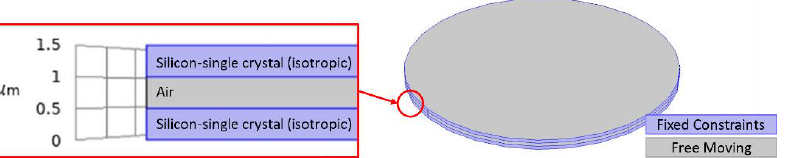
Figure 18. COMSOL Multiphysics ® software simulated clamped membrane geometry with a 40 µ m diameter. The top and bottom layers are composed of silicon-single crystal (isotropic) and the middle layer is an air cavity. The thickness of the top and bottom membranes and the air cavity height are 0.5 µ m each. Boundaries shown in blue are fixed while the grey boundaries are free to move. Frequency shift versus mass change is shown in Figure 19 for a silicon capacitive clamped membrane mass sensor with 40 μm diameter when the thickness of the top and bottom membrane and the cavity height were 0.5 μm. In these FEA simulations, the ca- pacitive membrane was fully clamped, and the sensor was biased with 20 V DC, which is chosen close to the device’s pull-in voltage, which results in a deflection towards the grounded bottom electrode. Solid mechanics and electrostatics effects in the capacitive clamped membrane are investigated through the stationary and eigenfrequency studies when user controlled fine mesh is applied to the structure with tetrahedral components.